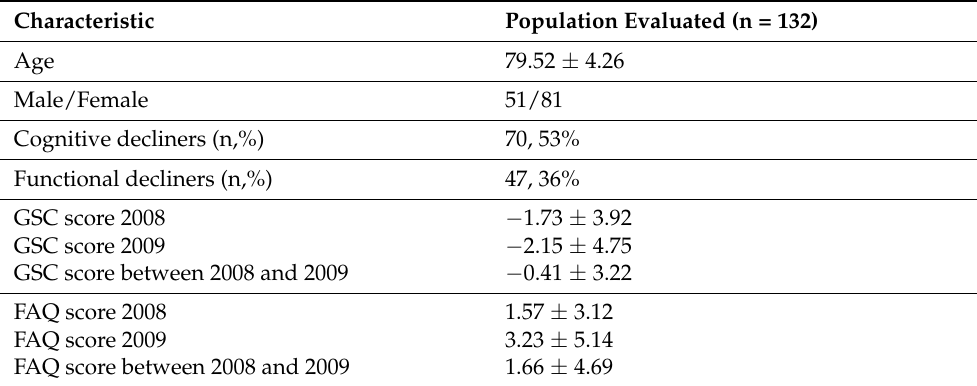
Table 1. Demographic characteristics of the population and cognitive/functional performance in